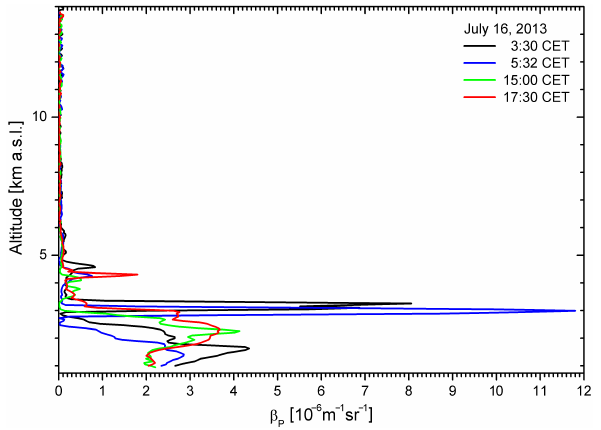
Figure 15. Ozone profiles for 16 July 2013. In the layers of strongly enhanced aerosol below 5km the ozone mixing ratio is several times slightly elevated (see arrows, colour chosen as in corresponding curves). Elevated ozone is seen also in other